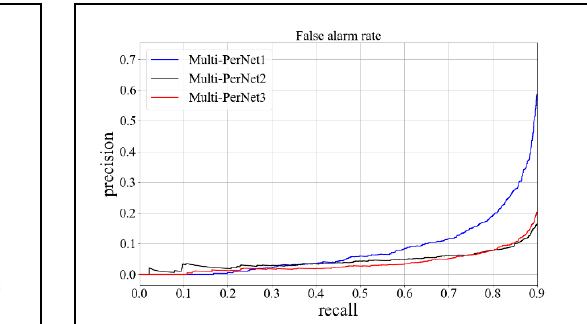
Figure 10. Comparison of three networks.